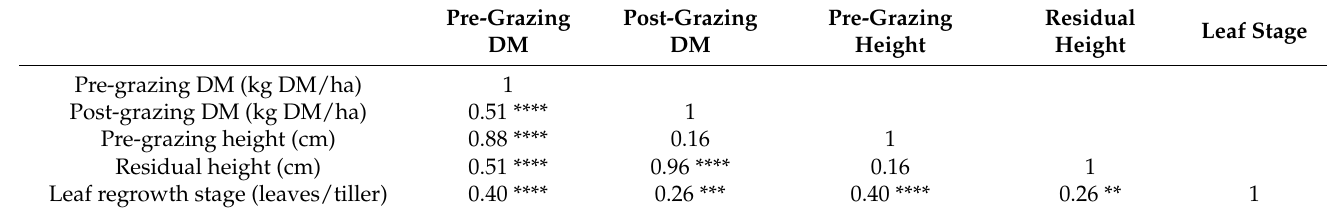
Table 6. The correlation matrix for the pasture measurements ( n = 112).